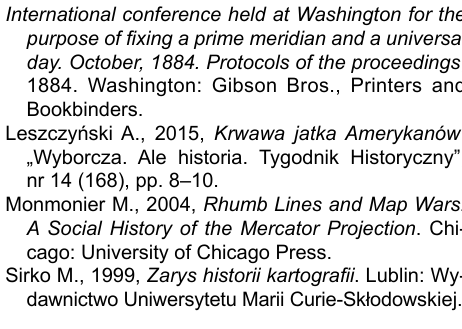
from it were used in the Polish school geograph- ical atlases. In some of the French atlases, such as Atlas Classique [23] from the same pe - riod, all the maps had the cartographical grids and the description of longitude according to the Paris Meridian.